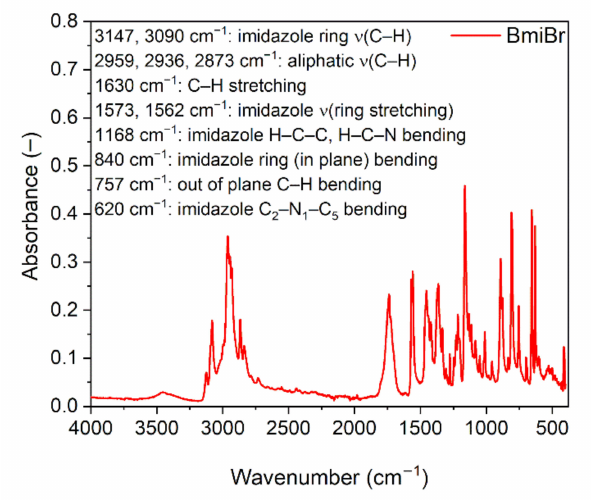
Figure 11. FT-IR spectrum of pure